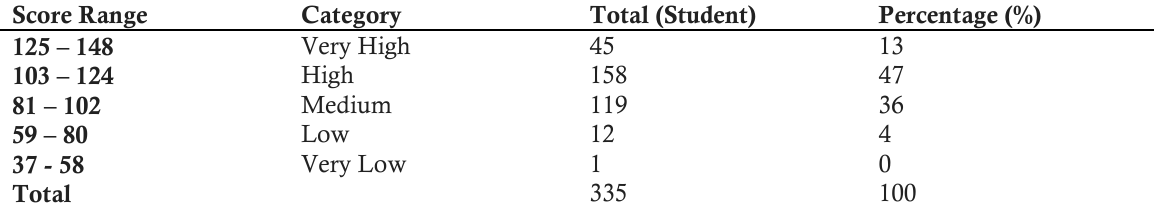
Table 3. Classification of Student Behaviour Prosocial